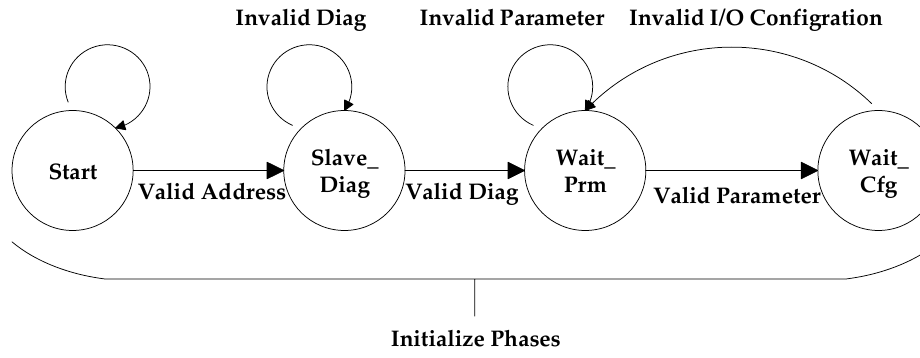
Figure 3. Initialization phase state transfer diagram.